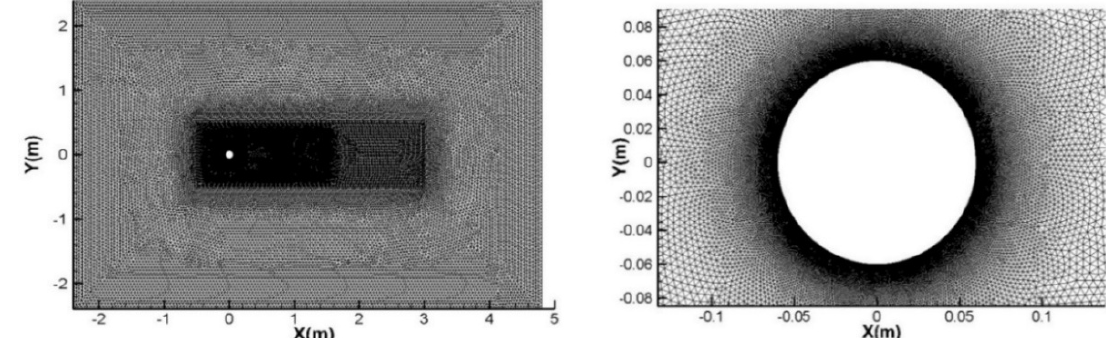
Figure 2. Grid distribution and computational domain near the cylinder surface.